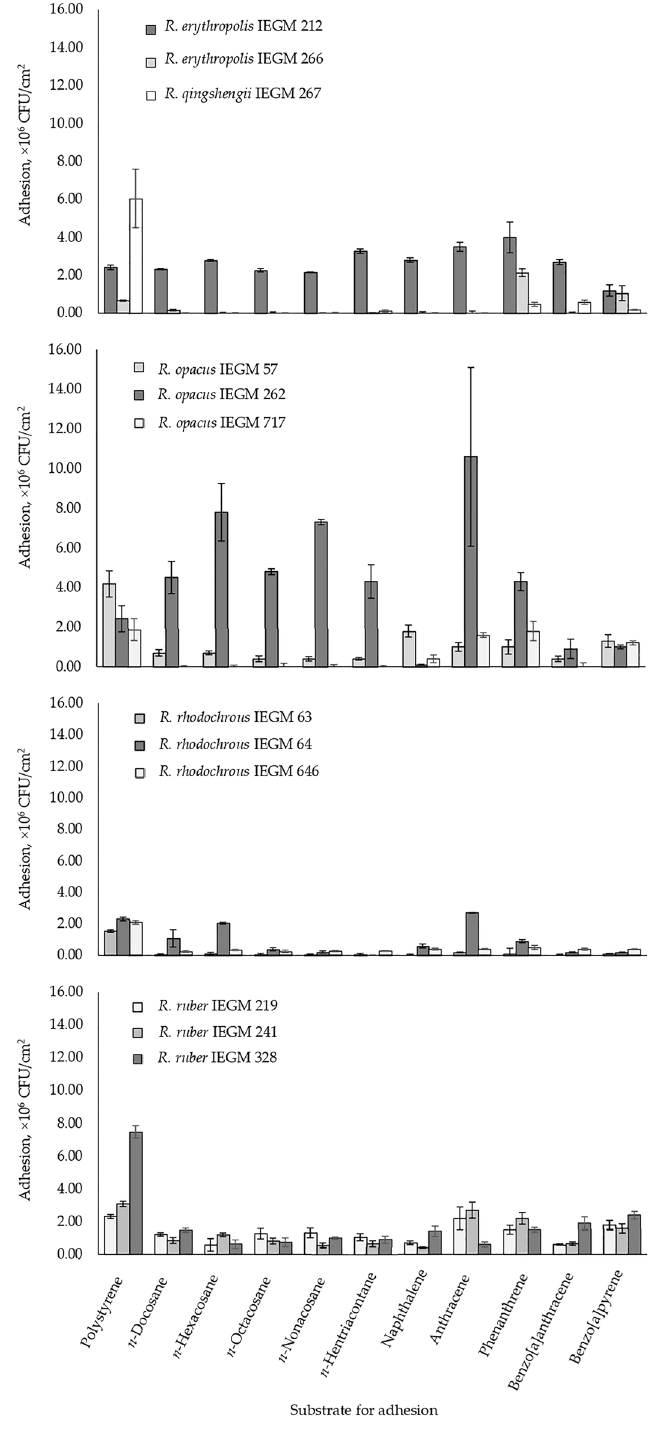
Figure 2. Adhesive activities of selected Rhodococcus strains towards C22–C31 n- alkanes, PAHs, and the reference solid surface